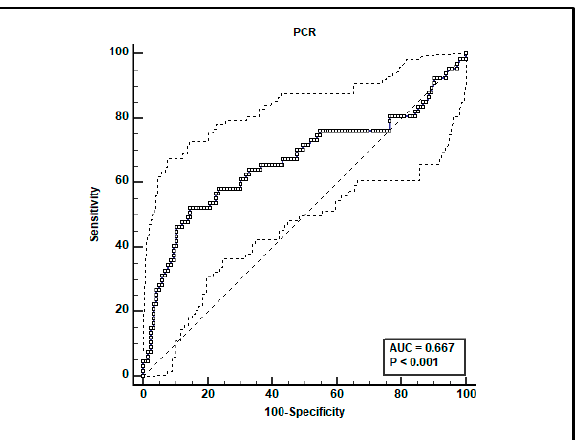
Figure 1. ROC curve analysis for voriconazole C min > 3 mg/L. An optimal cut-off of CRP value > 11.46 mg/dL was found with a sensitivity of 52.2% and specificity of 85.2%. A total of 161 paired voriconazole C min -serum procalcitonin (PCT) determinations